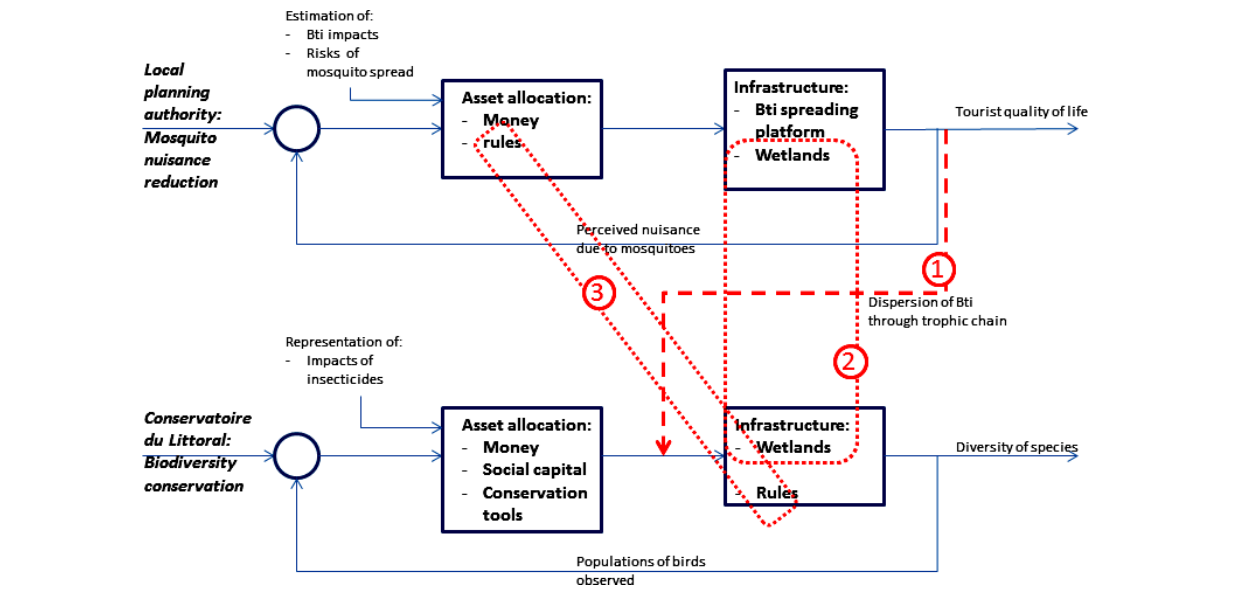
Fig. 7 . Vulnerability transfers observed in mosquito control in France. Bti, Bacillus thuringiensis israelensis